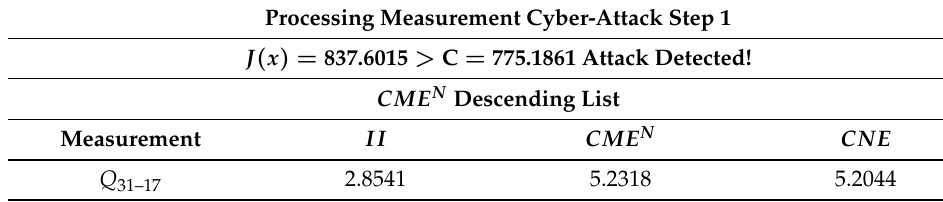
Table 5. Processing Cyber-attacks.